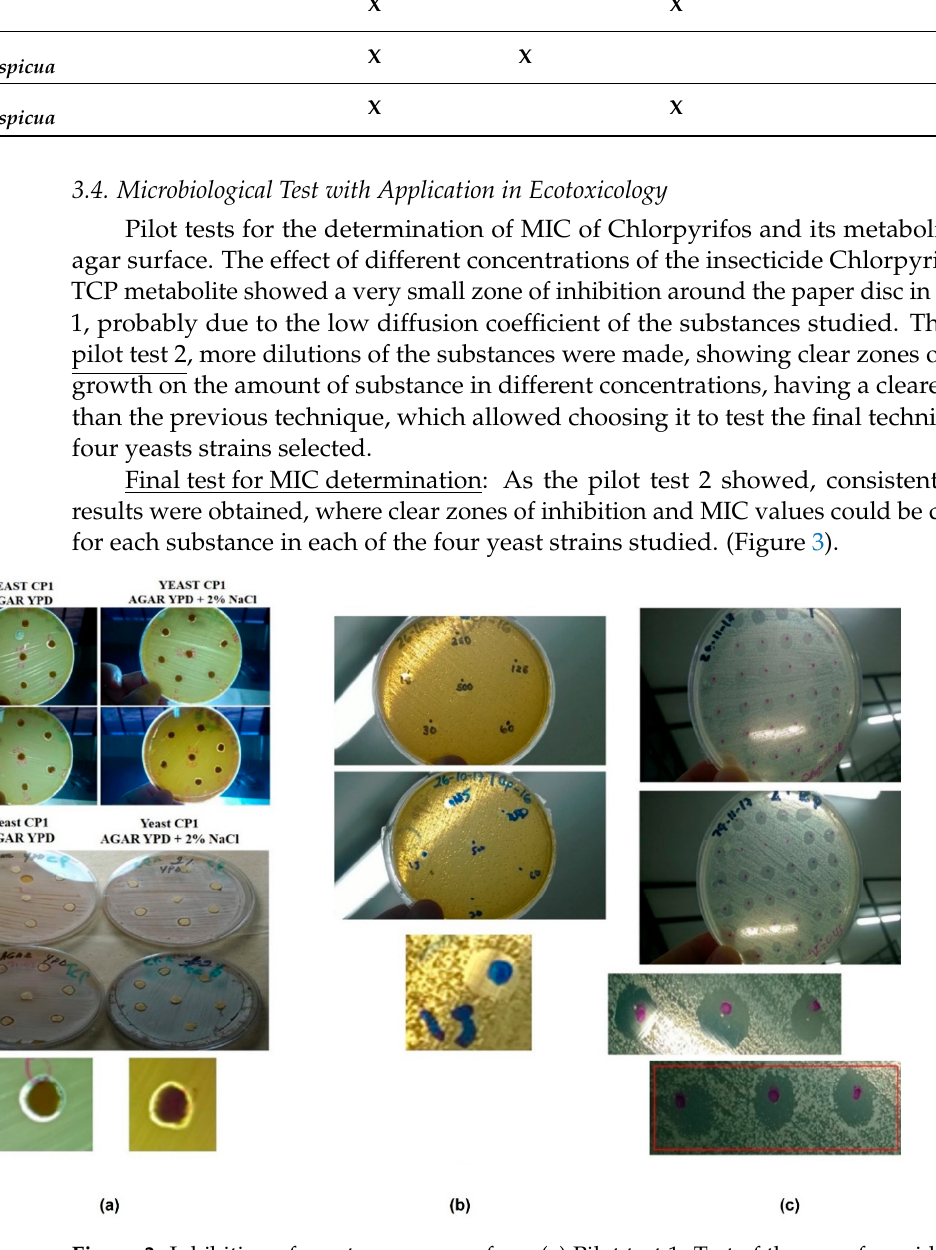
Table 4. MIC with direct CP and TCP technique on agar surface (4 yeasts). (+) Yeast growth on agar. (-) No growth of yeast on the agar.